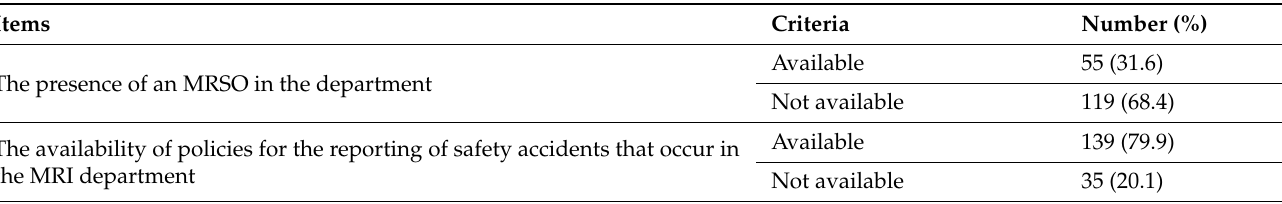
Table 2. Participants’ work